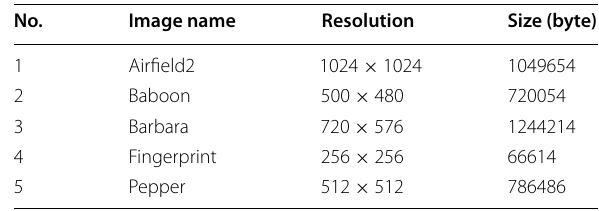
Table 2 Details of the test